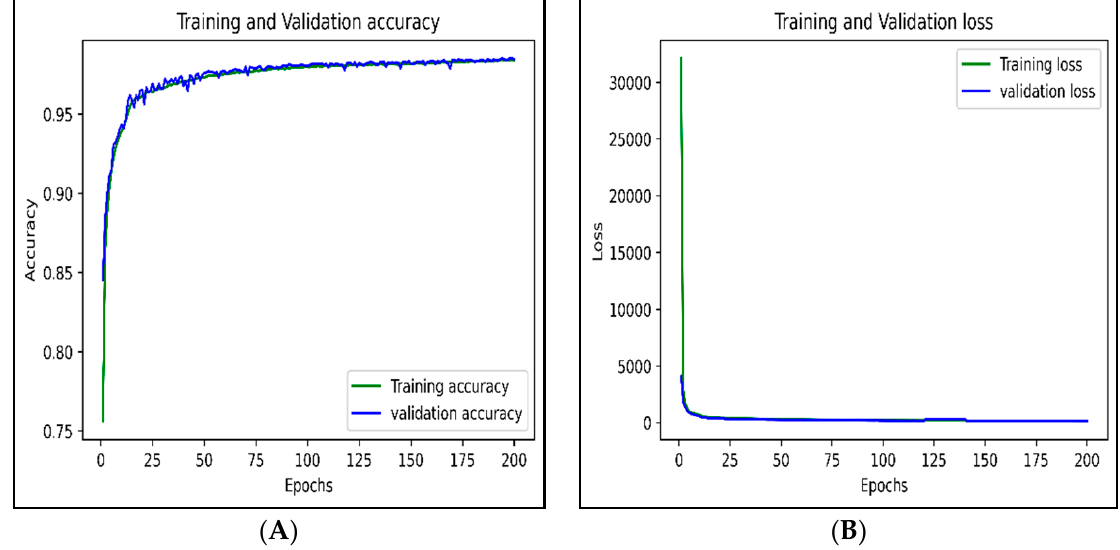
Figure 20. ( A,B ): Accuracy and Loss curves for Friday afternoon-DDoS sub-dataset. Figure 20. ( A , B ): Accuracy and Loss curves for Friday afternoon-DDoS sub-dataset.